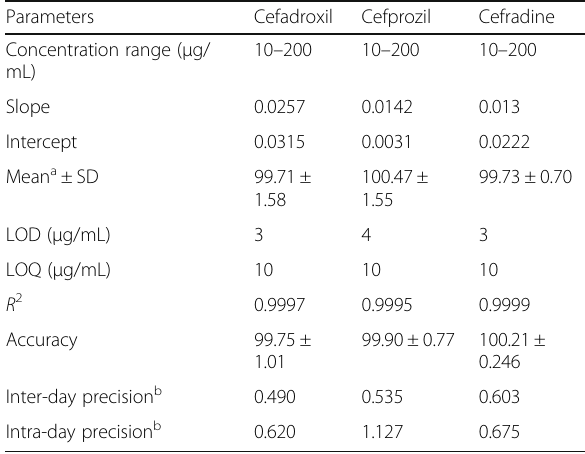
Table 3 Assay parameters and method validation obtained by applying the proposed HPLC-UV